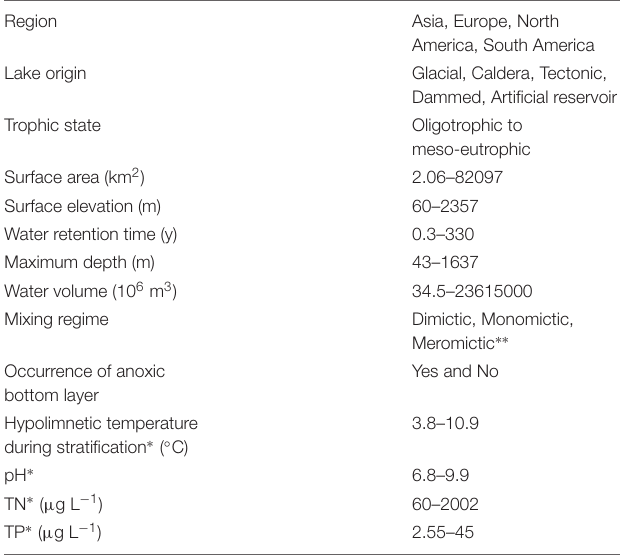
TABLE 3 | The range of environmental measurements of the lakes where CL500-11 were detected.